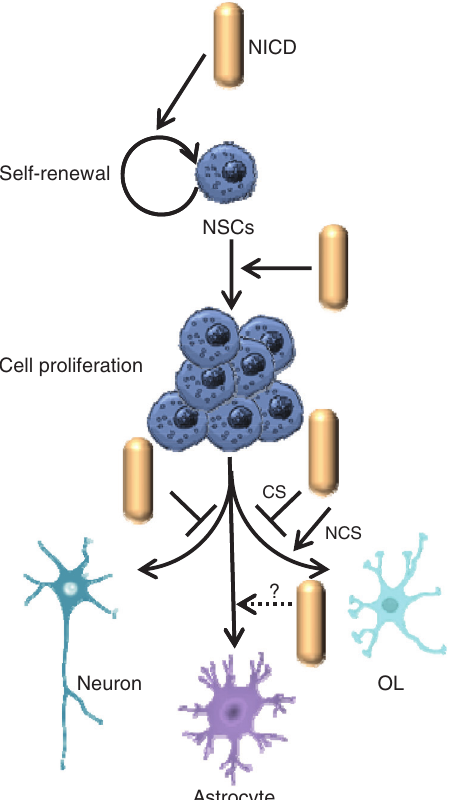
Figure 2 Role of NICD in NSCs renewal, proliferation and linage selection in adulthood. In the central nervous system, NICD medi- ates self-renewing divisions, and it has also been implicated in regulating quiescence of neural stem cells (NSCs). In progenitors, NICD is important for proliferation and de-differentiation. The most well-known role of Notch is the inhibition of neuronal differentiation of NSCs and progenitors. The activation of the canonical Notch sign- aling (CS) delays myelination, while the activation of the noncanoni- cal pathway (NCS) leads to OPC maturation into oligodendrocytes (OL) and myelination of axons. By contrast, the role of NICD in the switch from neurogenesis to gliogenesis to generate astrocytes still presents controversies (dotted